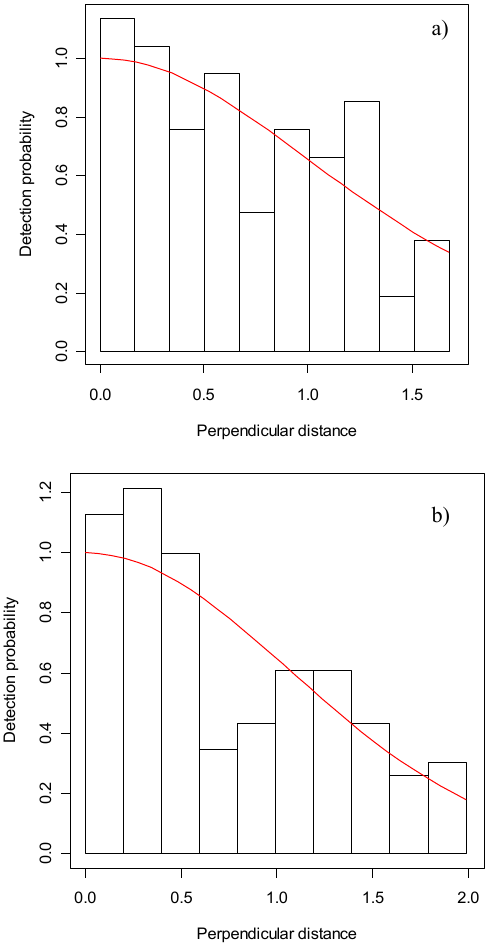
Fig. 4. Perpendicular distance (km) distribution and fitted half normal function (red line) for a) NASS-95 aerial survey and b) NASS-2001 aerial